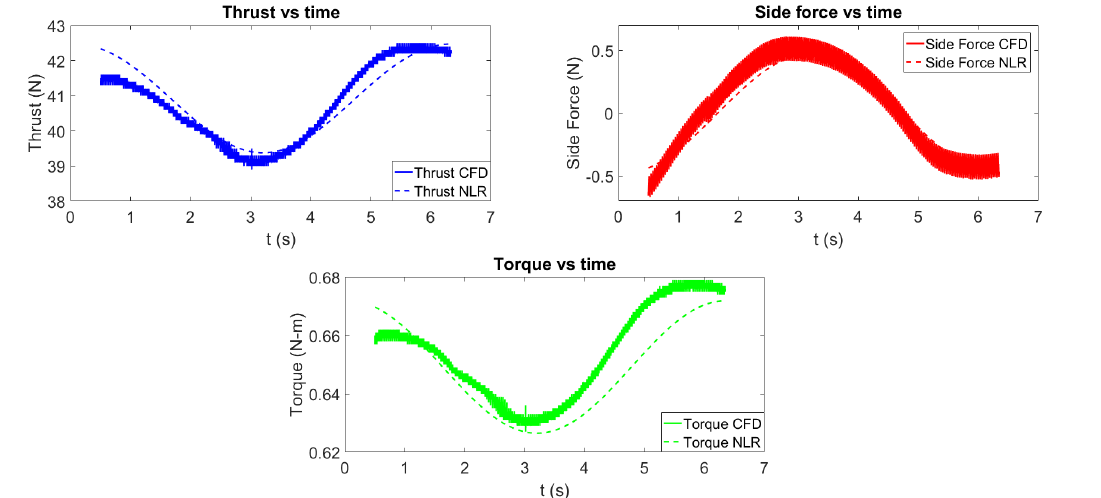
Figure 18. Behind condition nonlinear regression predictions of thrust, side force, and torque for Test 1 as a function of time.